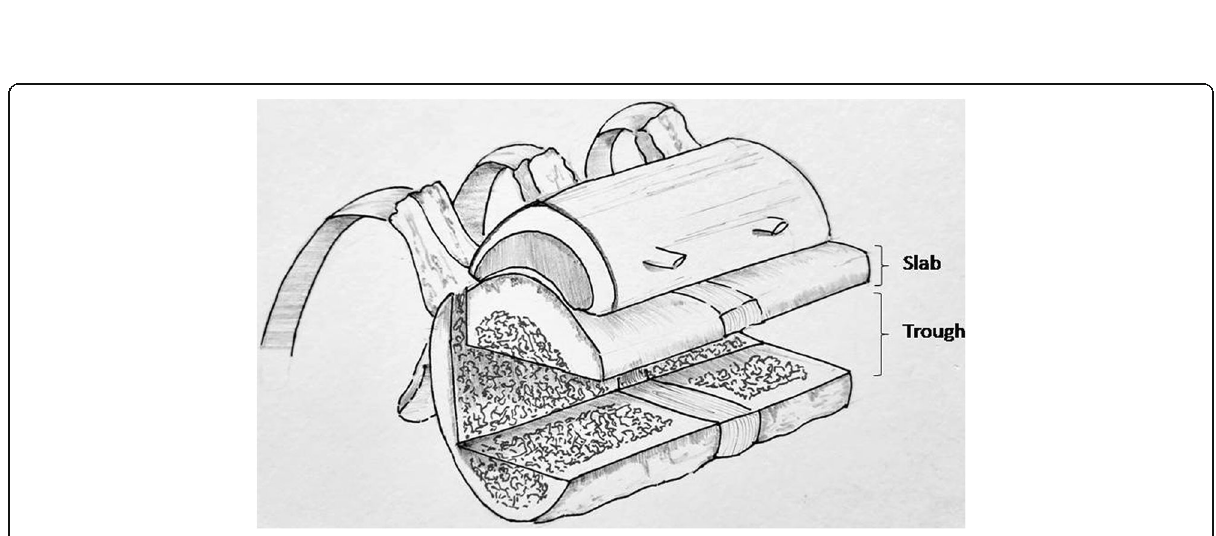
Fig. 4 Vertical cut being made on the opposite side to cut the bone block and slab ventral to the cord simultaneously. To be noted that after this cut the bone block is a free piece and the slab has still got distal and proximal attachments